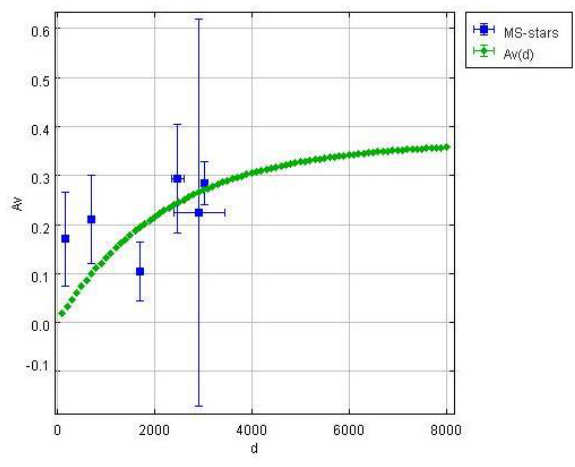
Fig. 3. A V ( d ) relation for area 5